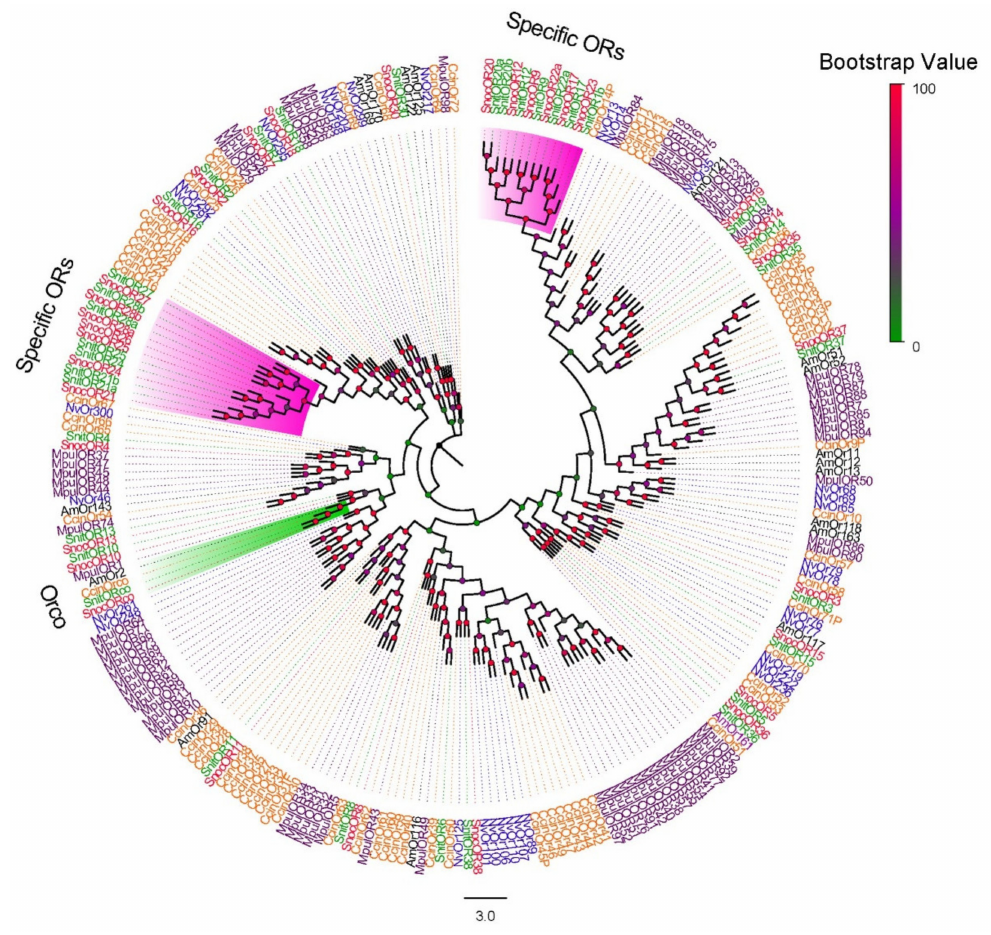
Figure 2. Neighbor-joining tree of 262 ORs from Hymenoptera species. The S. noctilio genes are displayed in red and S. nitobei genes are displayed in green. Mpul: M. pulchricornis ; Ccin: C. cinctus ; Nv: N. vitripennis ; Am: A. mellifera . The Amino acid sequences used for the phylogenetic tree were listed in Supplementary File